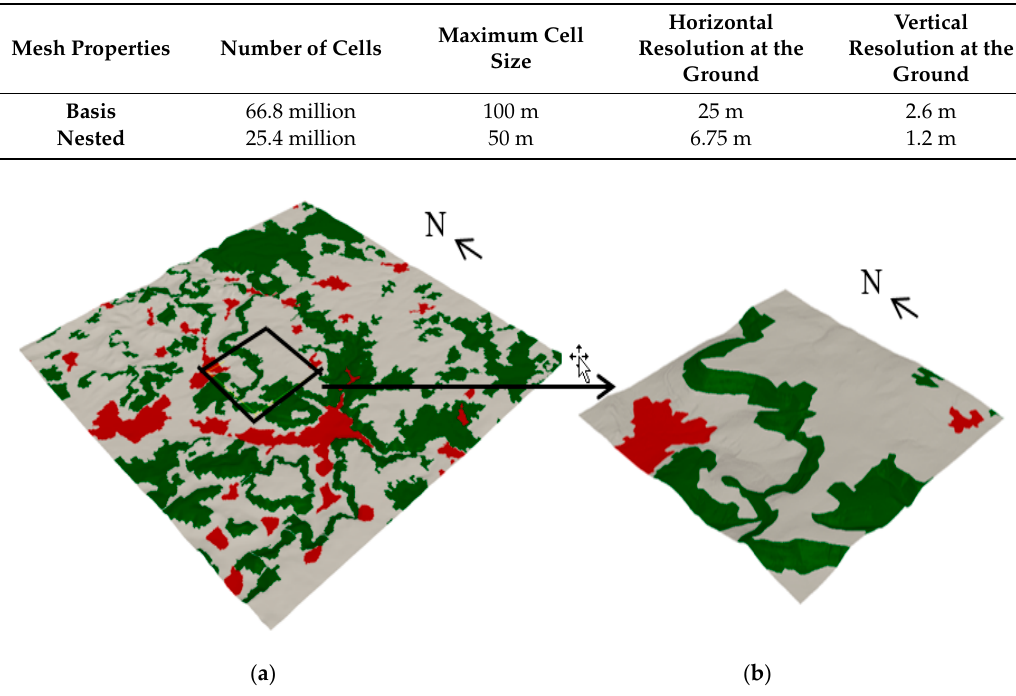
Table 4. Mesh resolutions for the domains.